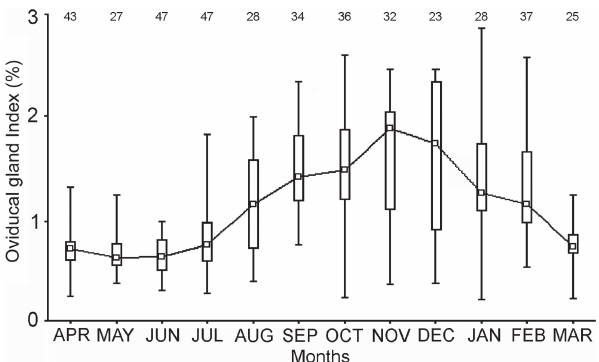
Fig. 8. Monthly variation of oviducal gland index (OGI) of mature females of Sympterygia bonapartii from San Matías Gulf (Argentina). Boxes indicate the percentiles 25-75%; the inner square indicates the median value and bars the range of data distribution. The number of samples is given in black.